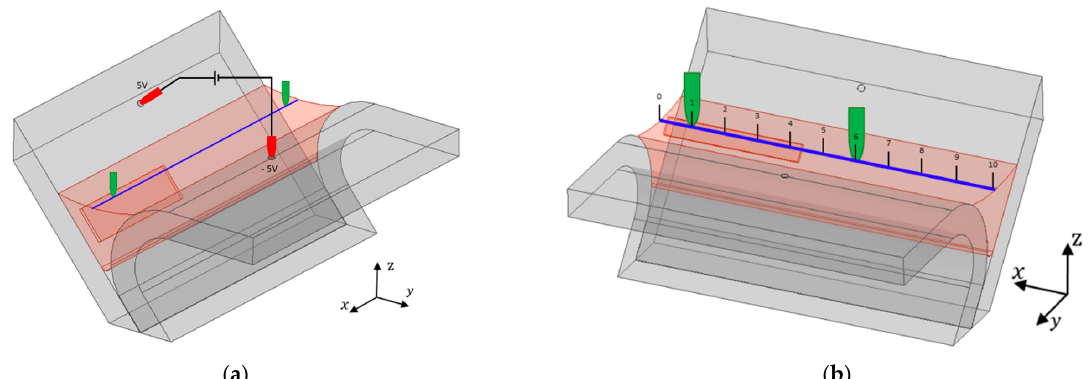
Figure 7. Electric equipotential lines from the top of the weld bead for an increasing defect in the X direction.